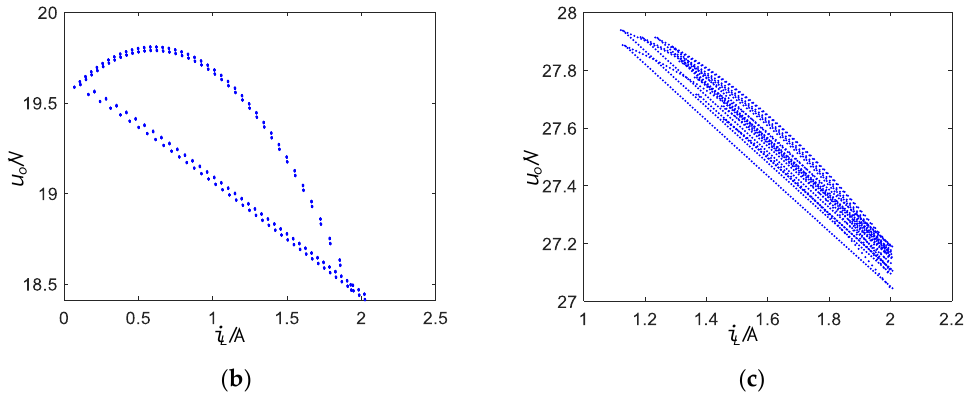
Figure 11. The V-I phase portrait of the FO buck–boost converter with different fractional orders: ( a ) α = β = 0.72; ( b ) α = β = 0.902; and ( c ) α = β = 0.99.